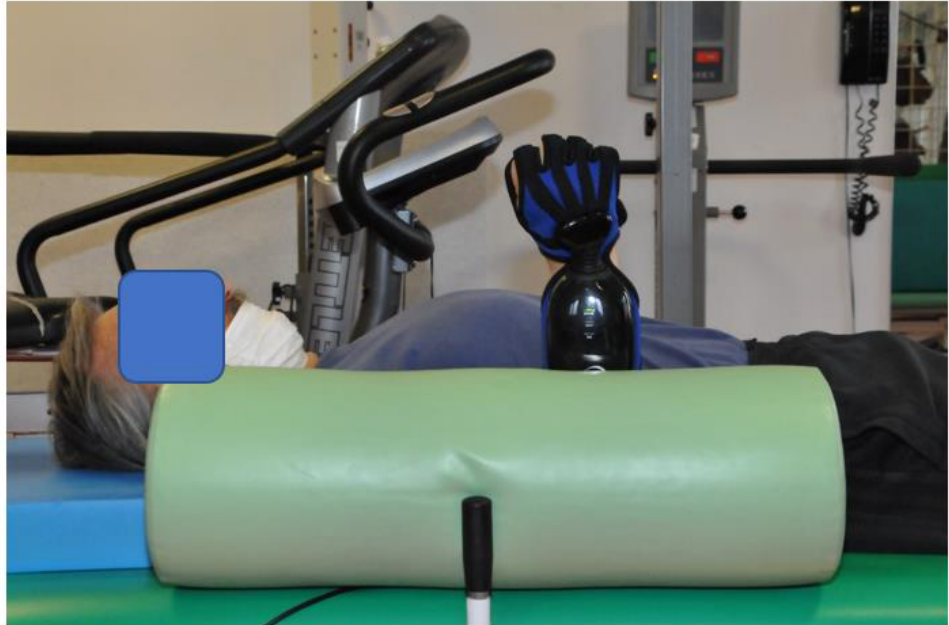
Figure 3. Illustration of patient placed in a supine position with the upper extremity held next to the body (i.e., adduction in the humeral joint, and elbow flexion in the intermediate position; passive stabilization of the trunk and shoulder).